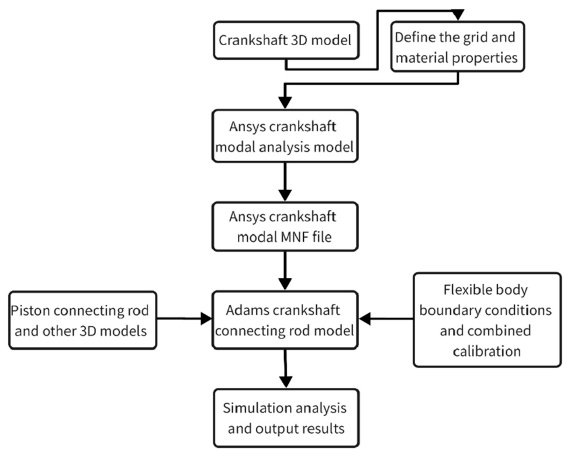
Figure 1. Flow chart for the fl exible multi-body dynamics modeling of the crankshaft.